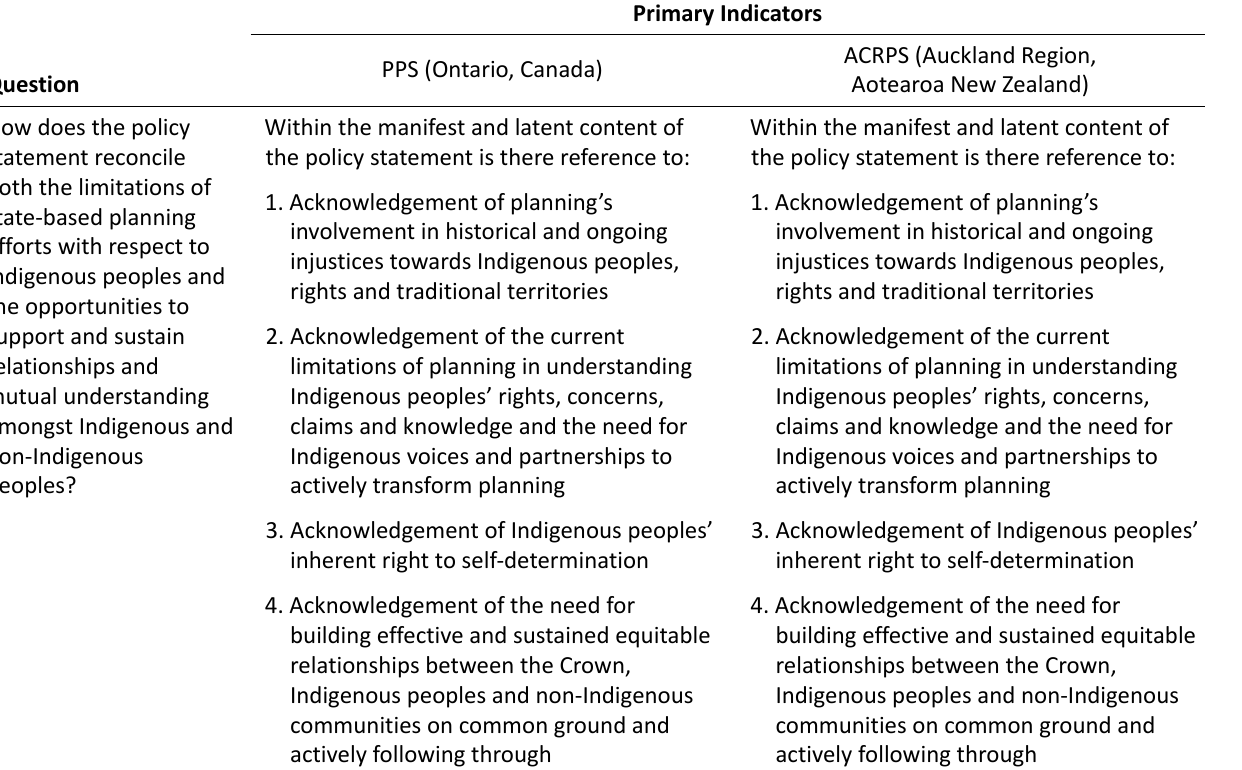
Table 4. Key aspects to Active Reconciliation in Reference to the Ontario Provincial Policy Statement and the Auckland Council Regional Policy